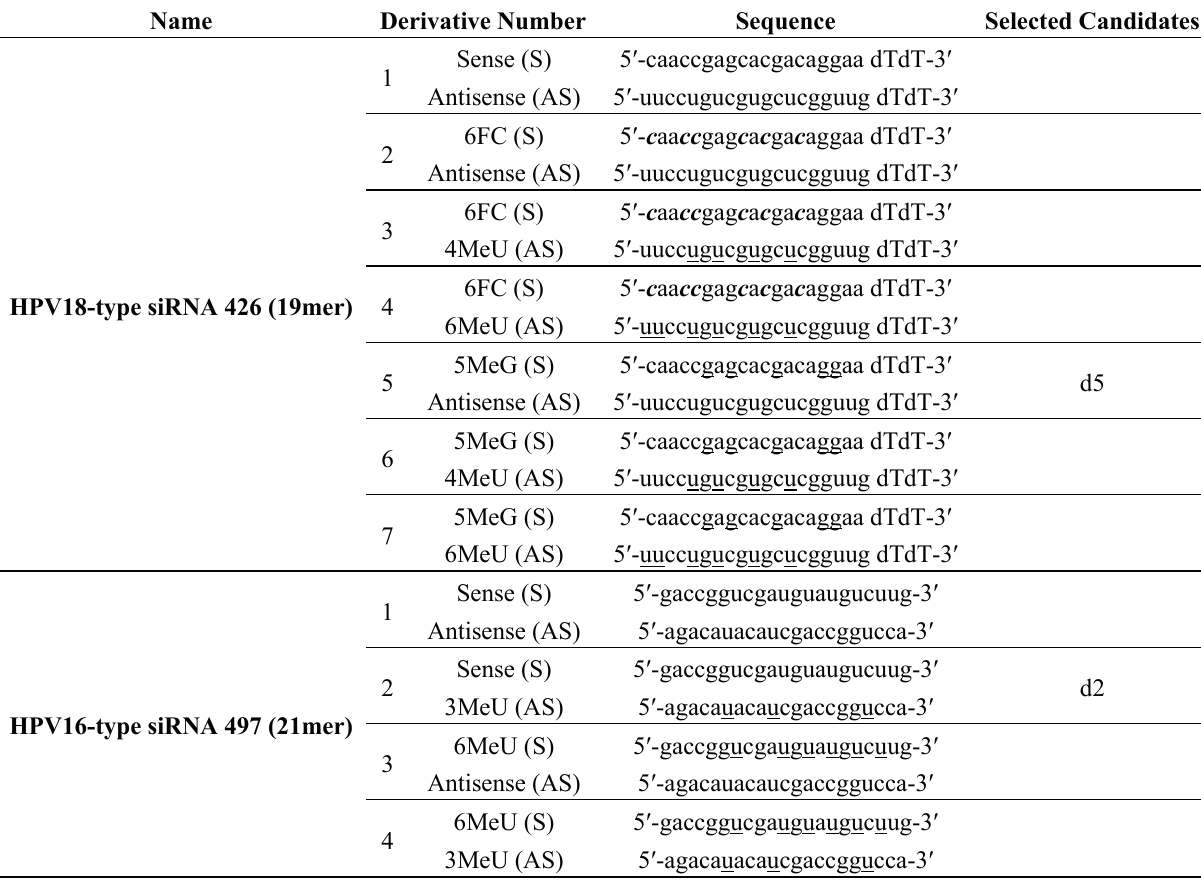
Table 2. List of selected siRNA derivatives used for chemical